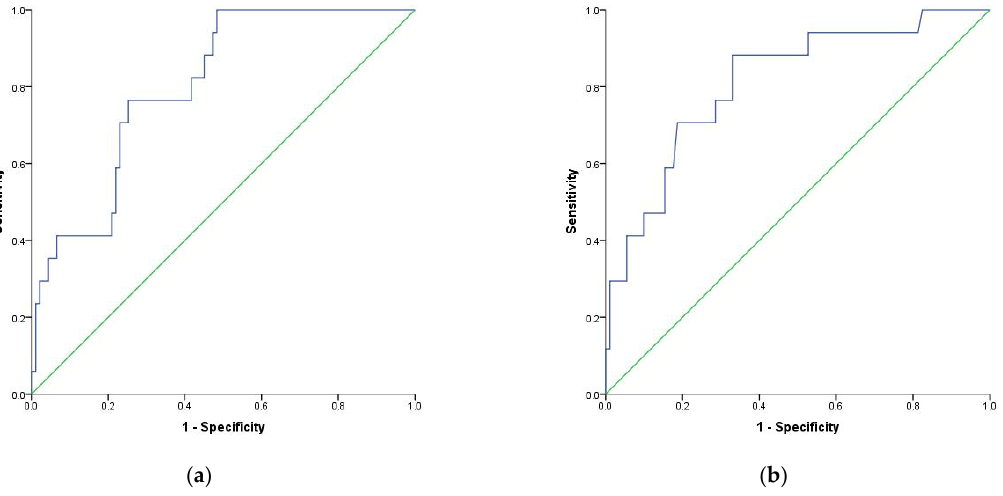
Figure 4. Receiver operating characteristic (ROC) curve for logistic regression models: ( a ) NLR (above or below 9.1) as a prognostic factor of mortality adjusted to age, sex and comorbidities index; ( b ) dNLR (above or below 9.6) as a prognostic factor of mortality adjusted to age, sex and comor- bidities.